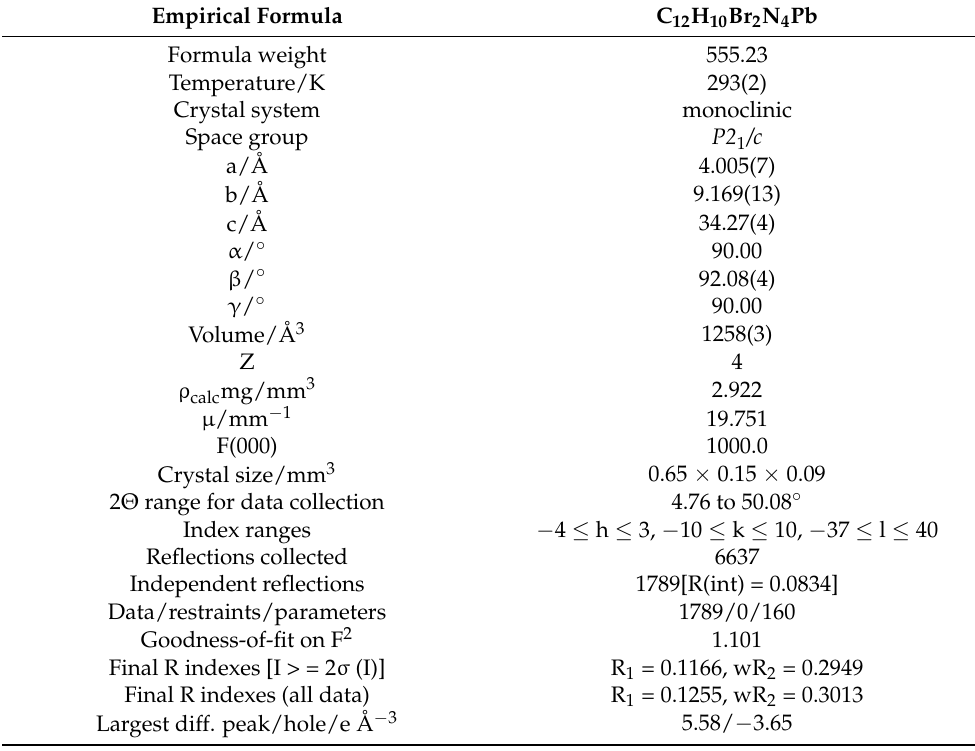
Table 1. Crystal data and structure refinement for [Pb(L)Br 2 ] n ( 1 ).